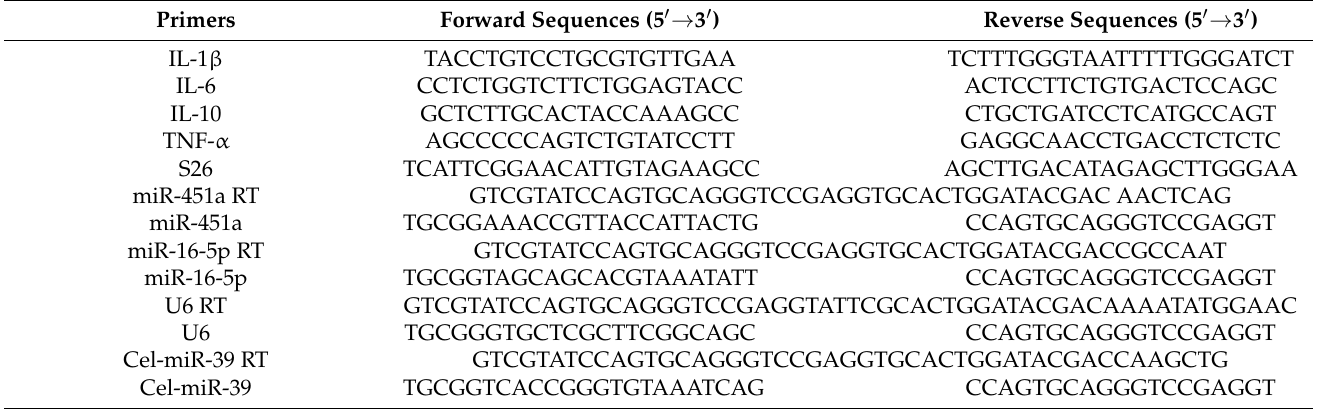
Table 1. Primers used in the